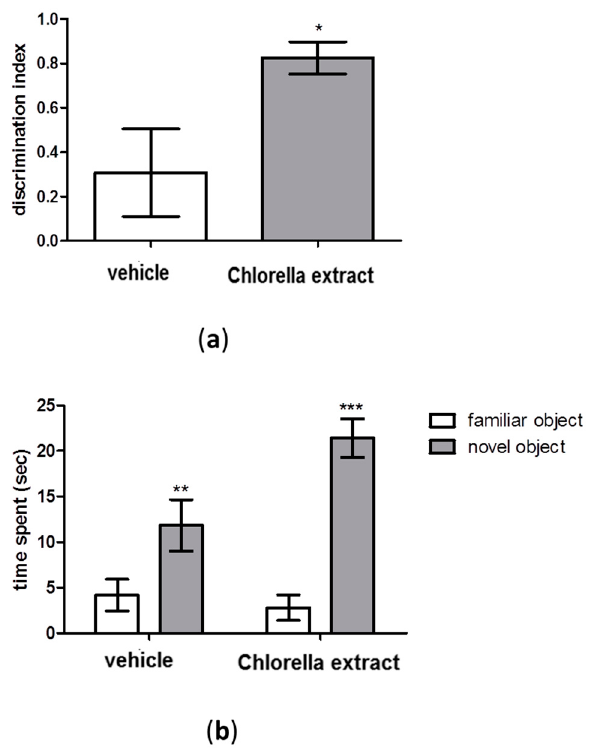
Figure 1. The NOR test in male Wistar rats after Chlorella sorokiniana extract or vehicle administration. ( a ) discrimination index and ( b ) time spent in the NOR test of male Wistar rats after Chlorella sorokiniana extract (Chlorella extract, 30 mg/kg/mL dark bar) or vehicle (sunflower oil 1 mL/kg, empty bar) administration. Data are expressed as mean ± SEM ( n = 8 per group); ( a ) t -test * p < 0.05 vs. vehicle-treated rats; ( b ) Two-way ANOVA followed by Bonferroni’s multiple comparisons test. ** p < 0.01 vs. familiar object and *** p < 0.001 vs. familiar object for vehicle- and for Chlorella sorokiniana -treated rats, respectively.